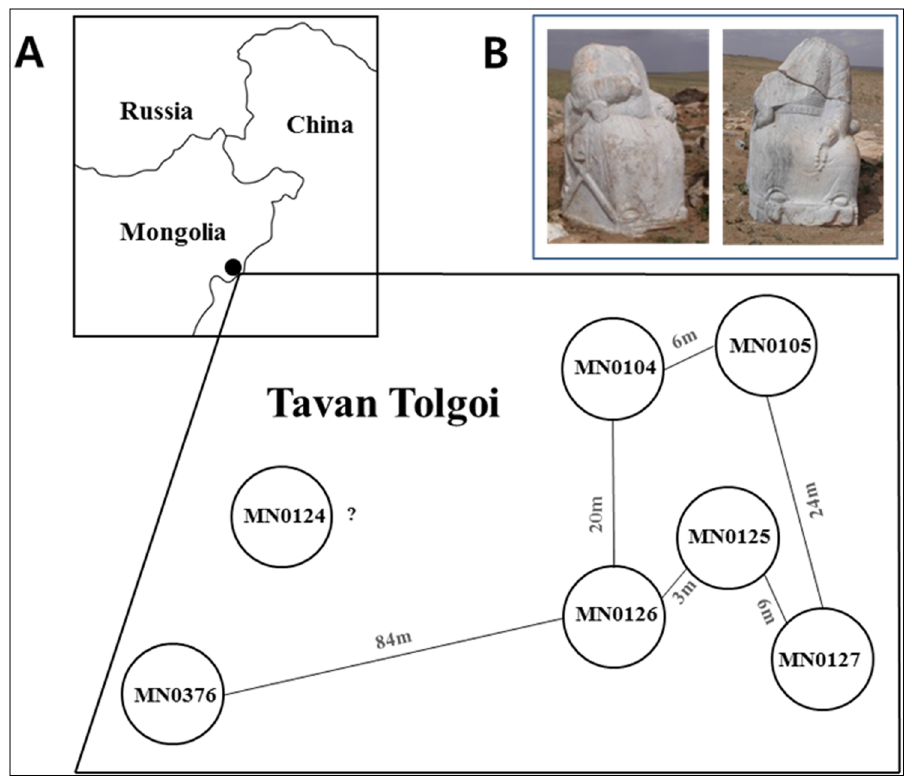
Fig 1. Geographical features of Tavan Tolgoi graves. A: A map of Tavan Tolgoi (top) and the relative geographical locations (bottom) of the graves excavated there. B: Two headless stone statues called Mongol King and Queen are located at the entrance of Tavan